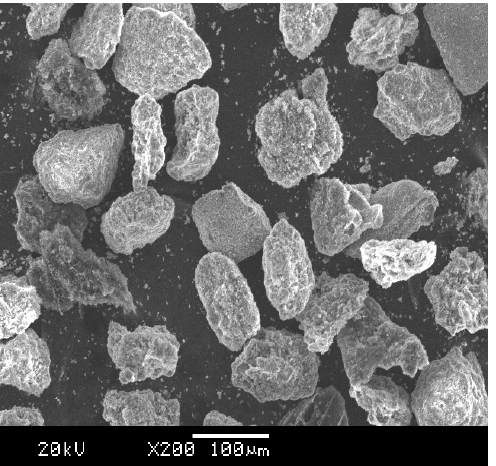
Figure 5. The microscopic morphology of the fly ash